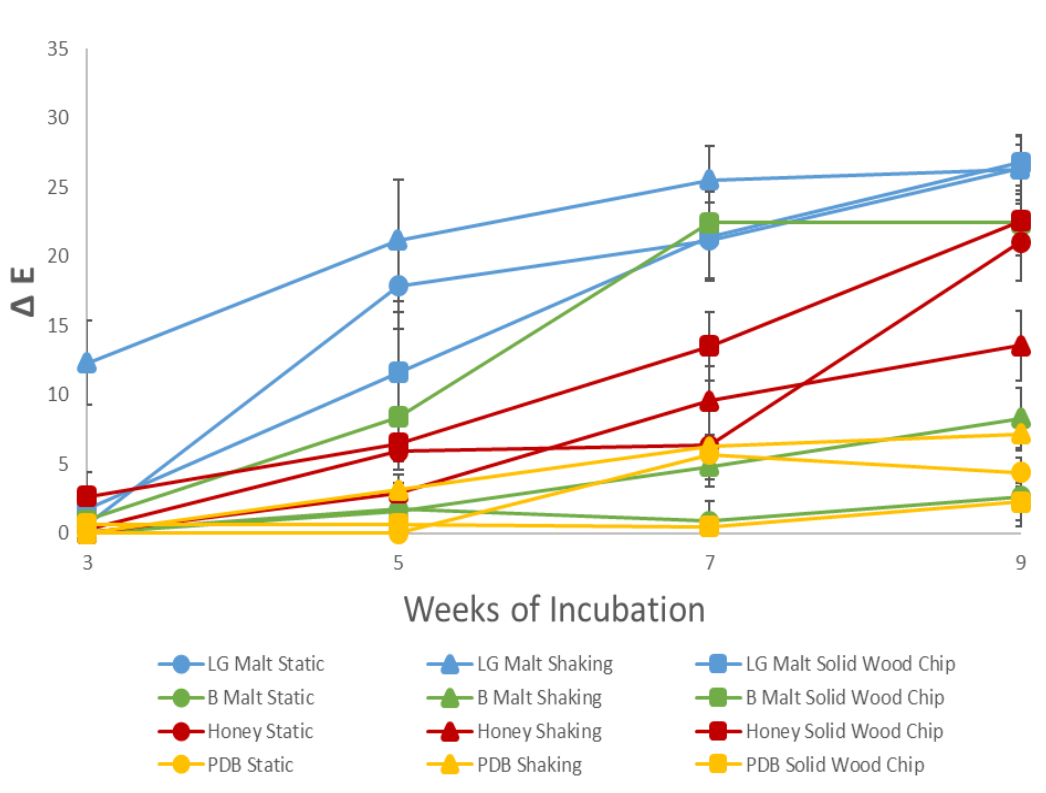
Figure 2. Mean color difference (ΔE) resulting from variation of media and cultivation technique. Error bars represent standard error. Interaction between media, week, and growth conditions tested with a Proc Glimmix model was found to be highly significant (df = 18,150, F -value = 13.47, p < 0.0001). Lab-grade (LG) bacteriological malt cultures achieved a much higher ΔE by week 3, showing the fastest pigment production by far compared to other media at that time. Lab grade media also showed the largest ΔE value by week 9, followed by brewer’s (B) malt woodchip plates and honey woodchip plates. Potato dextrose broth (PDB) showed the least pigmentation across cultivation techniques.